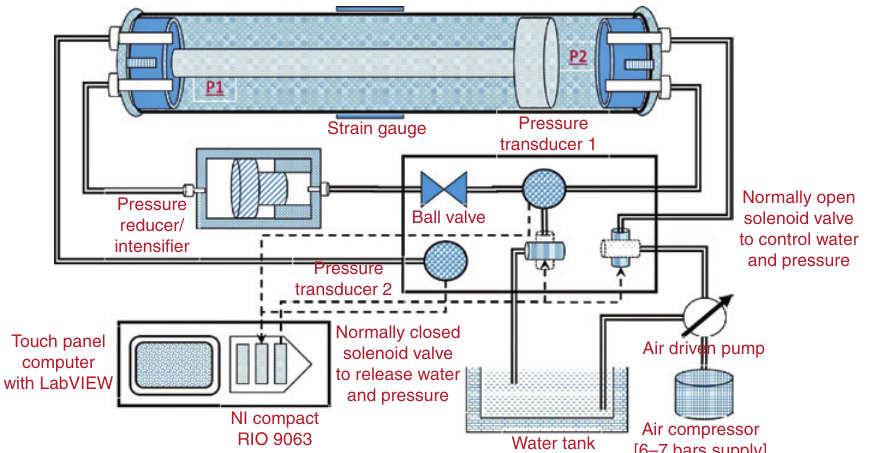
Figure 6: Schematic diagram of the automated portable pressure test